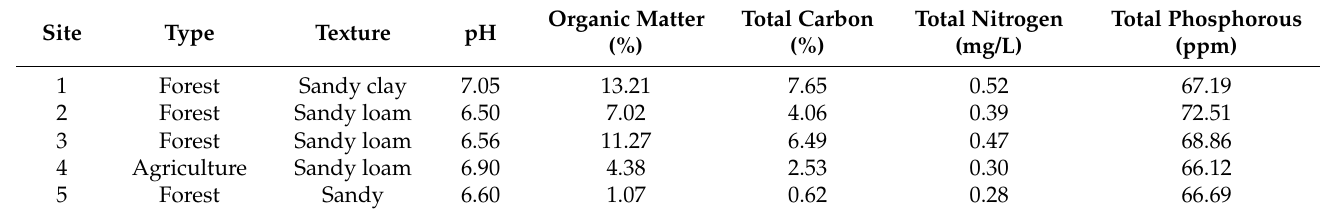
Table 2. Physical and chemical characteristics of soil